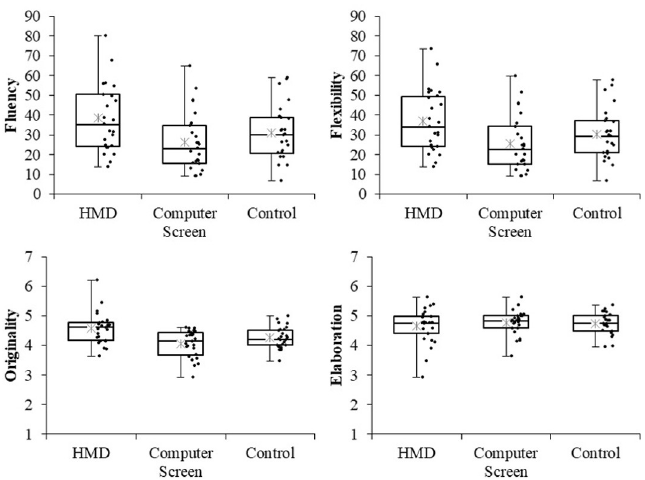
Fig 2. Boxplots and dot plots for each score (Experiment 1). Asterisks denote mean values.